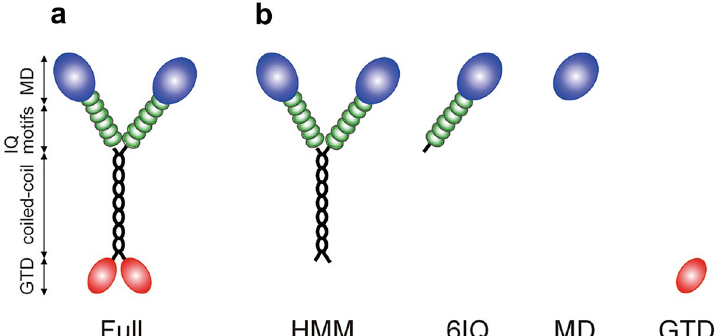
Figure 1. Schematic diagrams of the MYA2 constructs used in this work. ( a ) Full: Full-length construct comprising MD, six IQ motifs to which six calmodulins bind, coiled-coil, and GTD domains. ( b ) HMM: HMM construct comprising of MD, six IQ motifs to which six calmodulins bind, and a coiled-coil domain. 6IQ: 6IQ construct comprising of MD and six IQ motifs to which six calmodulins bind. MD: MD construct comprising only MD. GTD: GTD construct comprising only